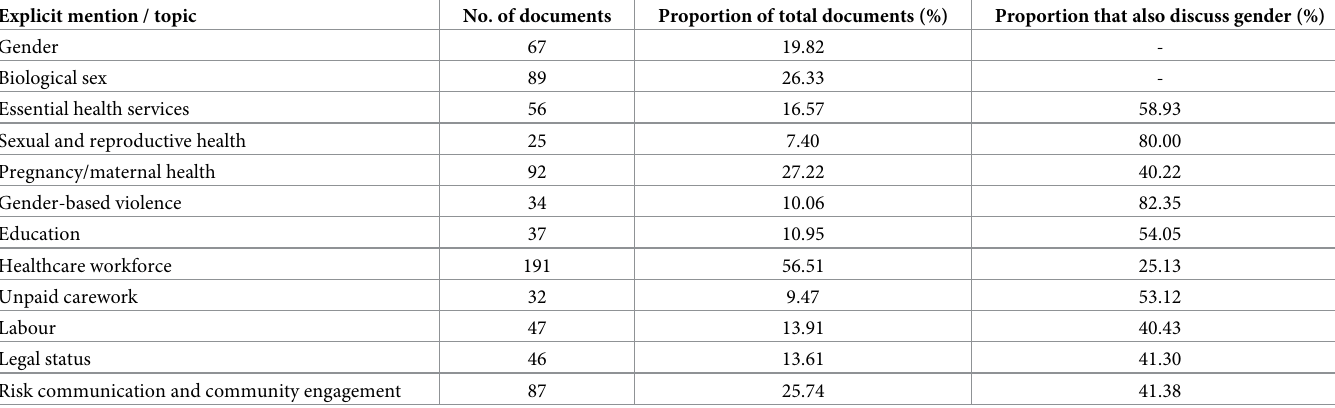
Table 1. Results of WHO COVID-19 policy analysis by gendered impact